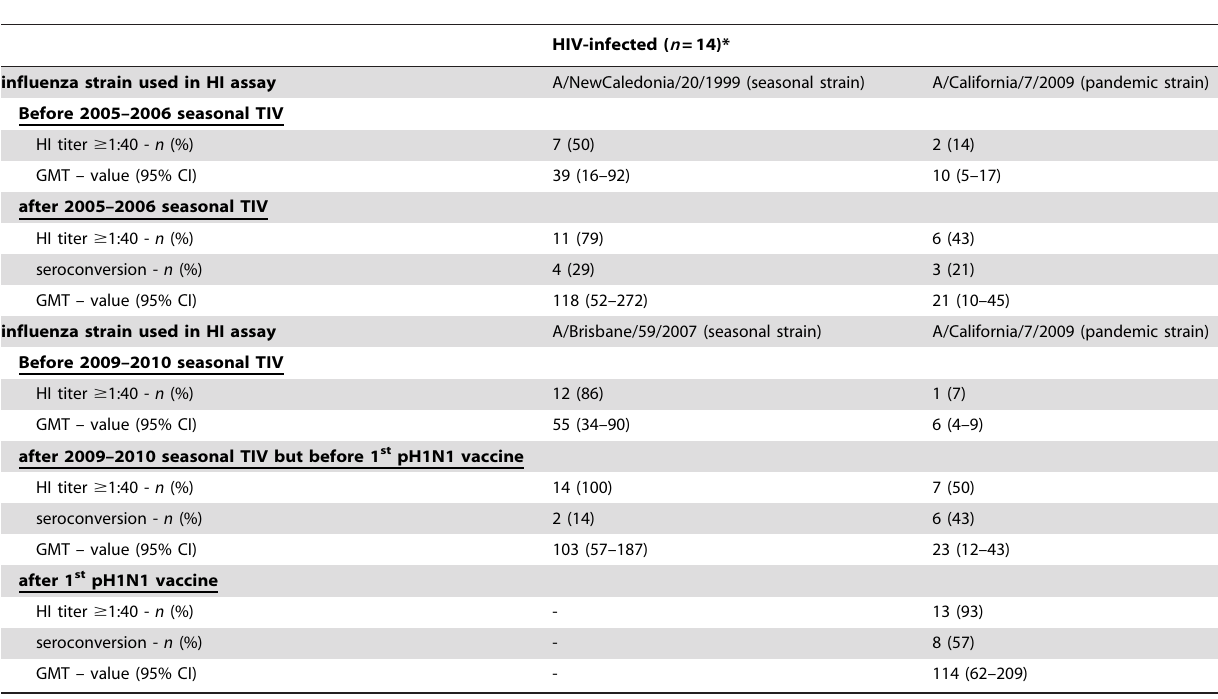
Table 3. (Cross-reactive) antibody titers following two different seasonal influenza vaccines in a cohort of 14 HIV-infected